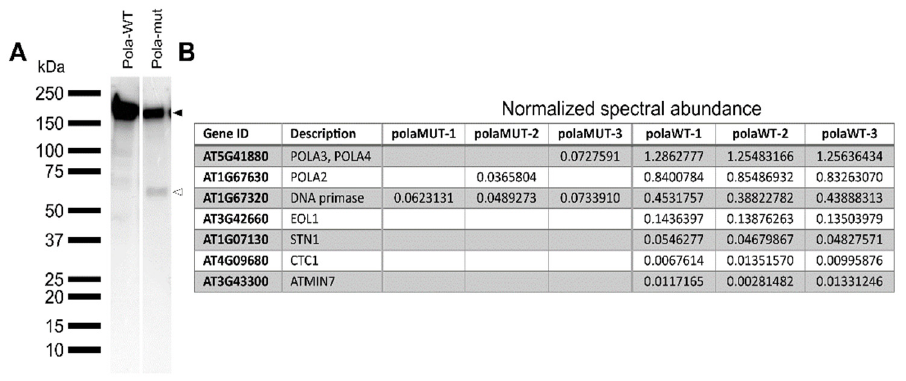
Figure 6. Identification of interactors of the wild-type and mutated form of DNA polymerase α . ( A ) Western blot of total protein extract using a peroxidase anti-peroxidase soluble complex antibody to detect the TAP fusion protein. Total protein was extracted from Arabidopsis PSB-D cell cultures transformed with N-terminally GSRhino-tagged WT (Pol α -WT) and mutated (Pol α -mut) form of DNA polymerase α . Extracts were run on the same gel in non-adjacent lanes. The black and white arrowheads indicate the full length and truncated protein form, respectively. ( B ) Proteins identified through tandem affinity purification of the constructs mentioned in ( A ). Values indicated are normalized spectral abundance factors, which are then normalized against the values of the bait protein, that was present in all samples. The three columns of each construct indicate three independent pulldowns of the protein. POLA3, POLA4: polymerase α primase subunit; POLA2: polymerase α regulatory subunit; EOL1: ENHANCER OF LHP1; STN1: SUPPRESSOR OF CDC13 HOMOLOG; CTC1: CST TELOMERE REPLICATION COMPLEX COMPONENT 1; ATMIN7: HOPM INTERACTOR